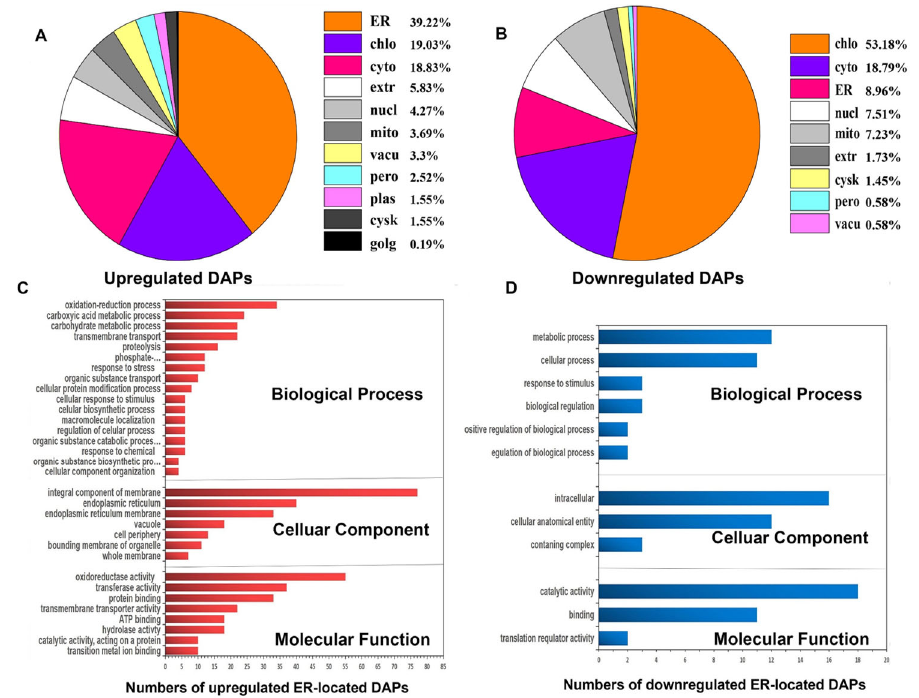
Figure 4. Subcellular localization and functional classification of the identified differentially accumulated proteins (DAPs) in wheat ER under salt stress. ( A ) Subcellular localization of 515 upregulated DAPs identified from wheat ER under salt stress. Chlo, chloroplast; cyto, cytoplasm; mito, mitochondrial; nucl, nucleus; vac, vacuole. ( B ) Subcellular localization of 346 downregulated DAPs identified in wheat ER under salt stress. Chlo, chloroplast; cyto, cytoplasm; mito, mitochondrial; nucl, nucleus; per, peroxisome. ( C ) Functional classification of the ER ‐ localized upregulated DAPs under salt stress. ( D ) Functional classification of the ER ‐ localized downregulated DAPs under salt stress.